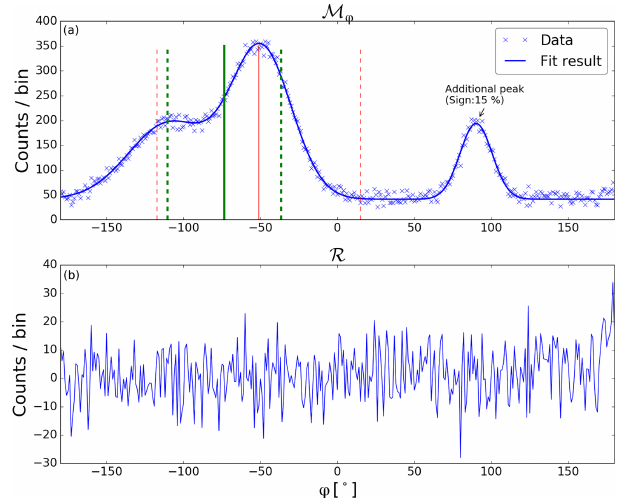
Figure A1. (a) Example fit result (blue line) of a multi-peak anal- ysis applied to synthetic data (blue crosses). (b) Corresponding fit residual. The data set consists of three Gaussian Normals includ- ing Gaussian noise (with σ noise = 9 counts). Two overlapping peaks are located at µ = − 110 ( A = 150 , σ = 25 ) and µ = − 50 ( A = 300 , σ = 20 ) (forming the predominant peak) and one additional peak at µ = 90 ( A = 150 , σ = 10 ) with a significance of 16%. Ex- pectation parameters ( ϕ µ , ϕ σ ) are indicated with solid and dashed vertical lines, respectively. The latter were retrieved as described in Appendix A3, both including and excluding the additionally de- tected peak at µ = 90, in red and